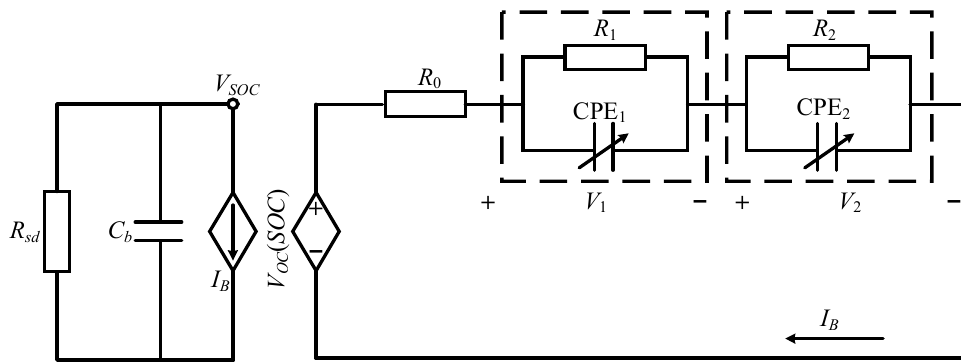
Figure 2. Electrochemical impedance circuit model of battery.